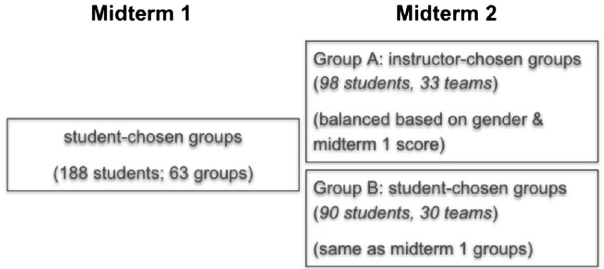
FIG. 1. Randomized experimental design illustrating the for- mation of the two types of groups for midterm 2. Students were randomly assigned to two groups. Group A students were assigned to groups balanced on the basis of gender and midterm 1 score. Teams were carefully constructed to ensure two con- ditions were met: (i) all groups had the same average score from the first midterm and (ii) there were no groups with a single (isolated) female student. Group B students were assigned to the same groups they had chosen for midterm 1.